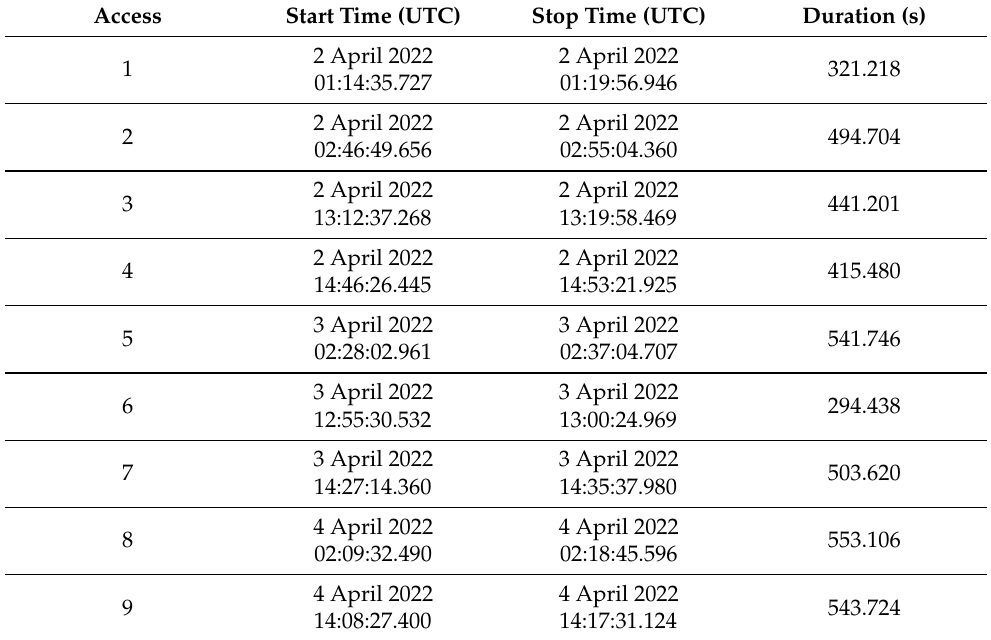
Table 4. Ground station to AlfaCrux first access